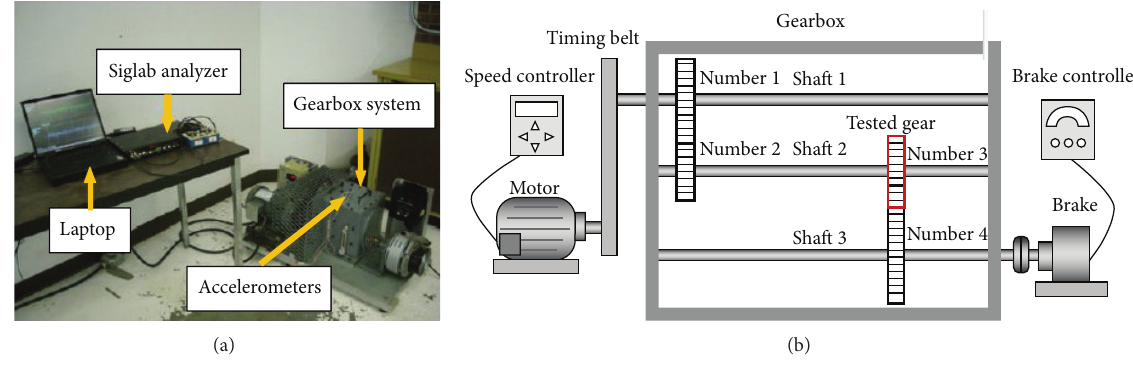
Figure 3: Experimental setup [24]: (a) a real picture; (b) a sketch map. Table 1: The geometries of different gear crack